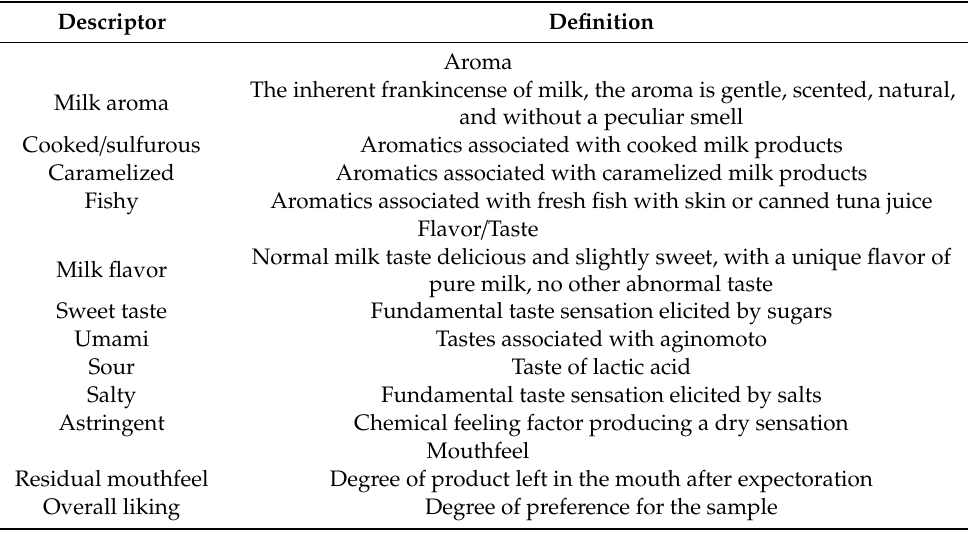
Table 3. Sensory descriptors and their definitions for the skim